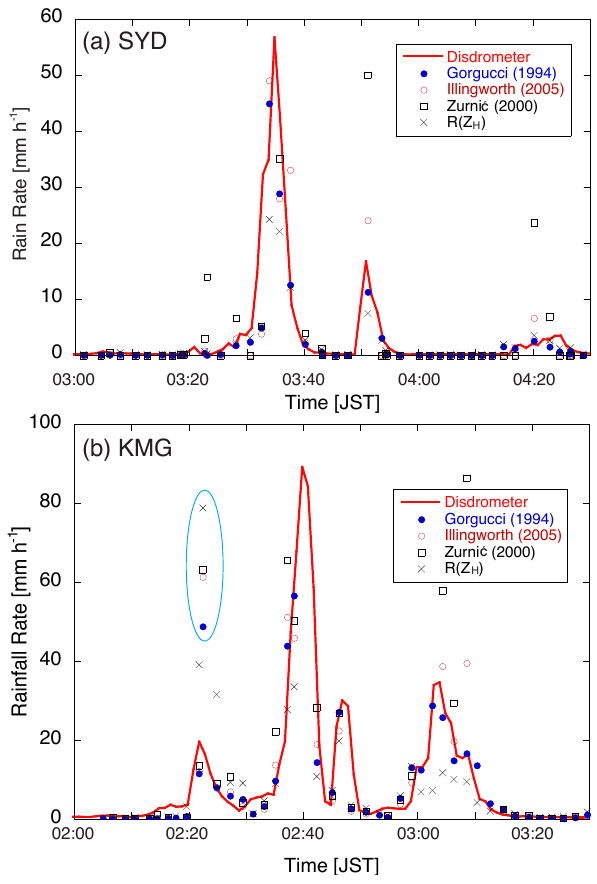
Figure 5. Rainfall rate comparisons between disdrometer measurements (solid line) and MRI Fig. 5. Rainfall rate comparisons between disdrometer measure- C-band polarimetric radar estimations using the R ( Z H , Z DR ) method (circles and squares) and the ments (solid line) and MRI C-band polarimetric radar estimations R ( Z H ) relationship (crosses) at (a) Sekiyado (SYD) and (b) Kumagaya (KMG) surface stations from using the R(Z H , Z DR ) method (circles and squares) and the R(Z H ) 03:00 to 04:30 JST and from 02:00 to 03:30 JST on 7 July 2010, respectively. A blue ellipse in (b) relationship (crosses) at (a) Sekiyado (SYD) and (b) Kumagaya surrounds outliers of rainfall rate estimated from the C-band radar at 02:22 JST. (KMG) surface stations from 03:00 to 04:30JST and from 02:00 to 03:30JST on 7 July 2010, respectively. A blue ellipse in (b) sur- rounds outliers of rainfall rate estimated from the C-band radar at